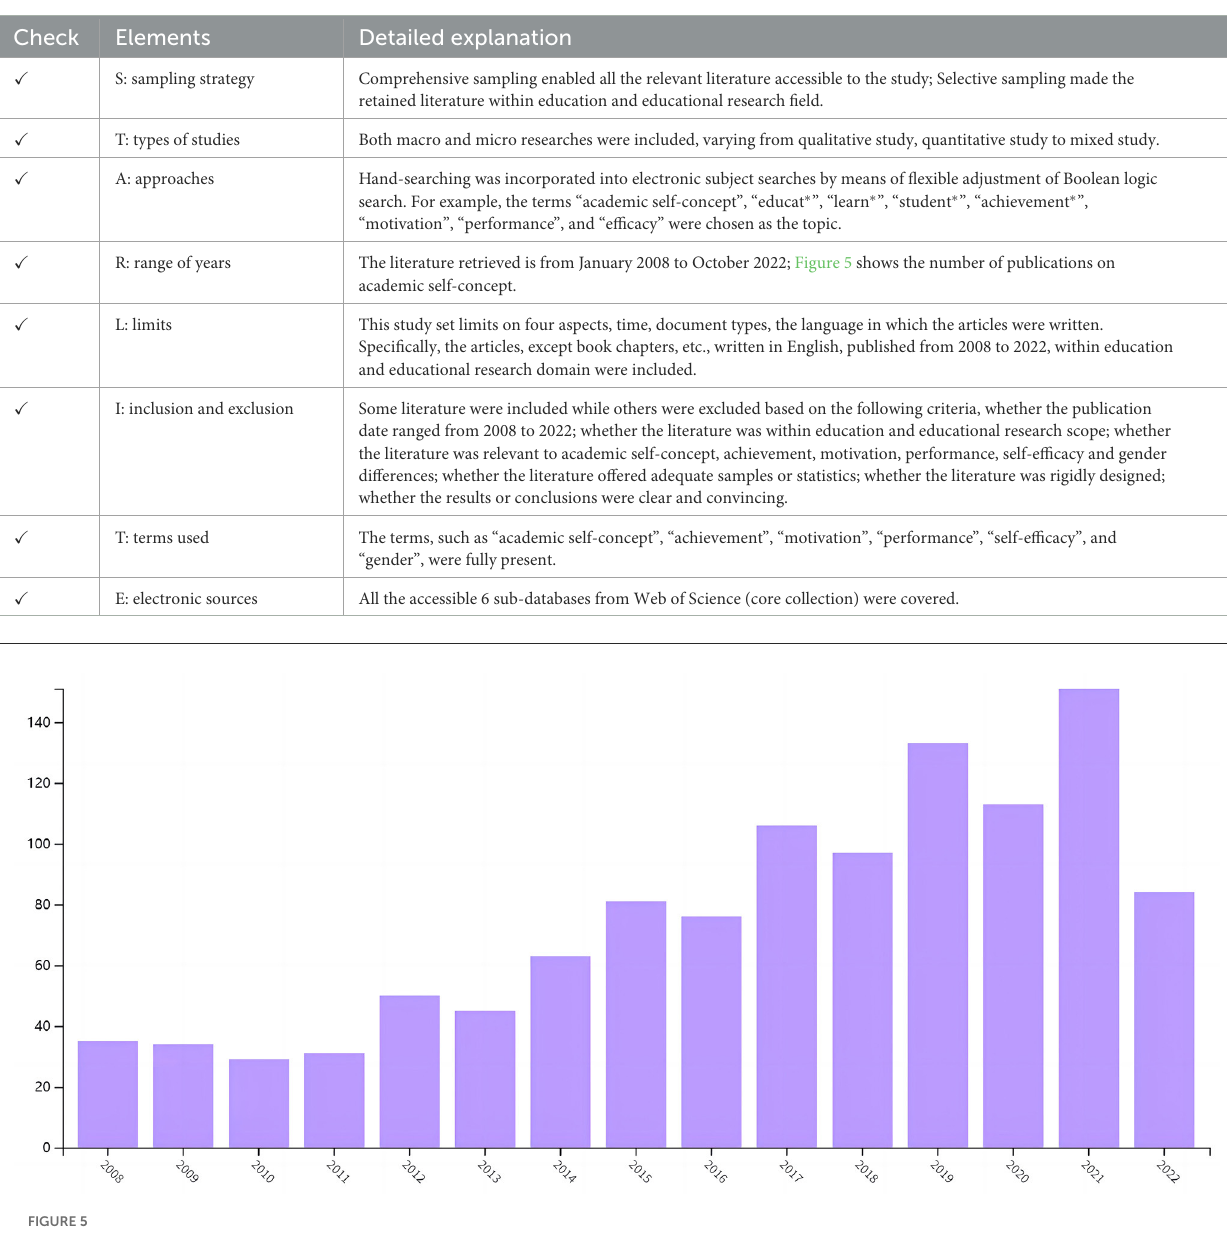
TABLE 2 Self-check based on STARLITE.